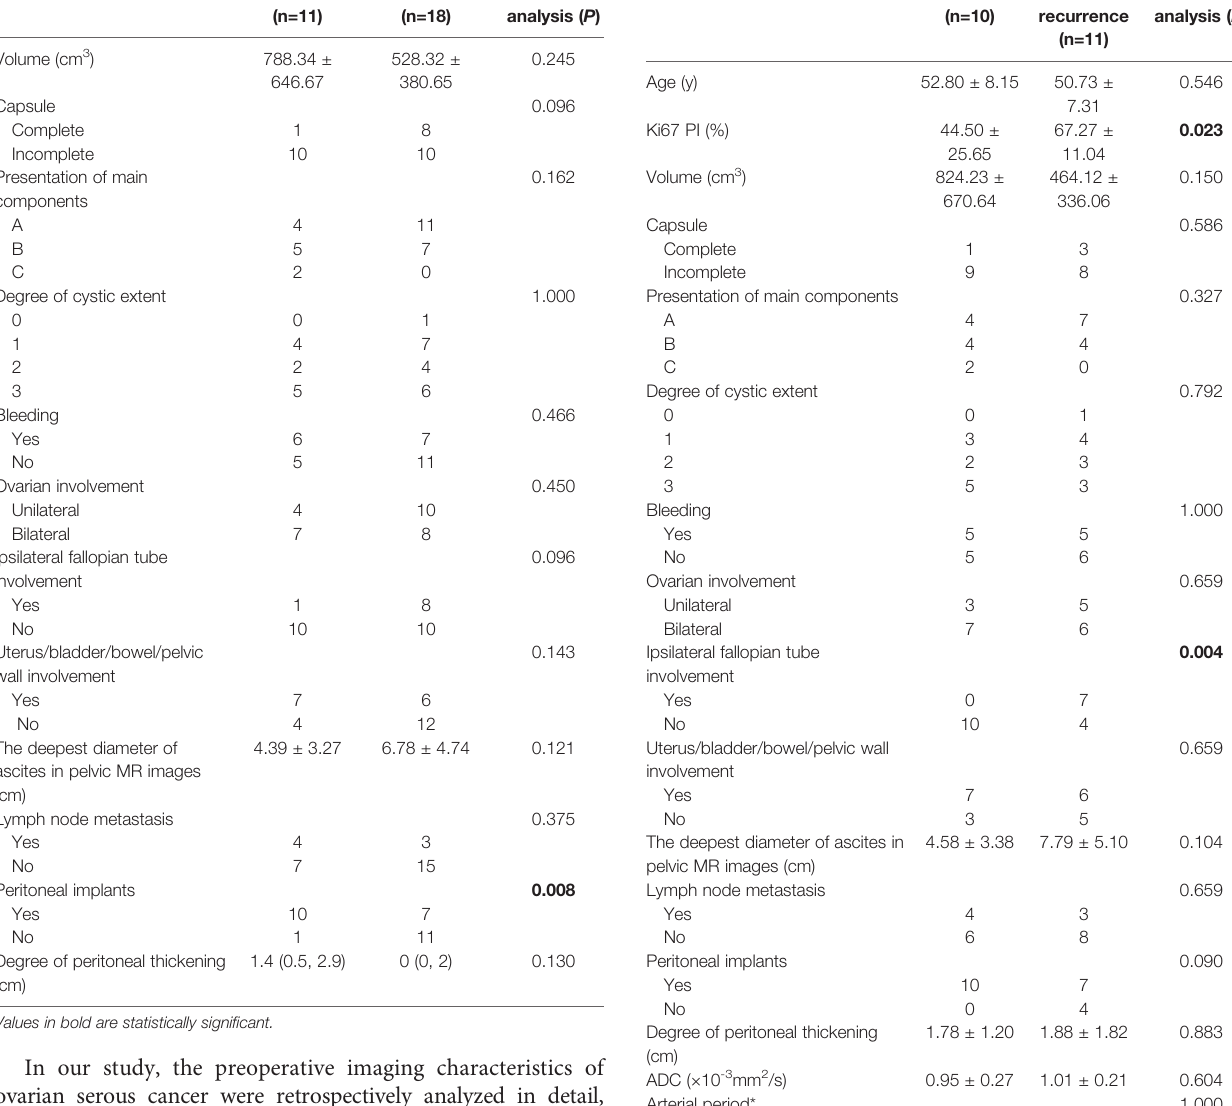
TABLE 4 | The univariate analysis of the ovarian serous carcinoma on FIGO III between the recurrence and no recurrence groups. Indicators